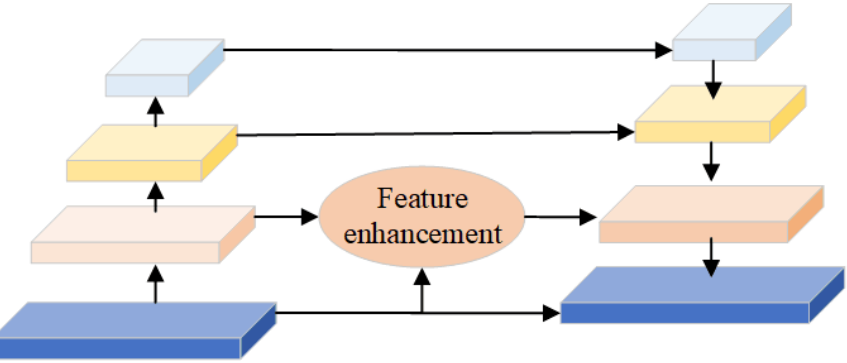
Figure 5. The architecture of the feature pyramid network. The FPN is used to produce multi-scale feature representations.